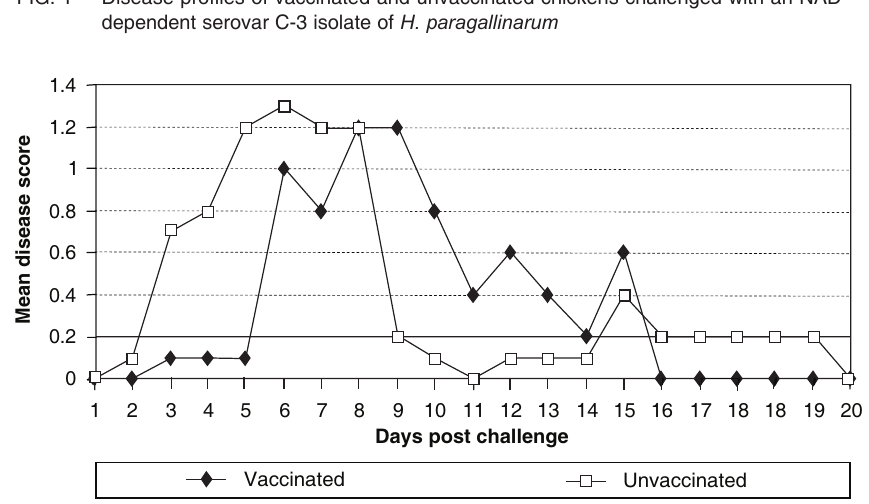
FIG. 1 Disease profiles of vaccinated and unvaccinated chickens challenged with an NAD- dependent serovar C-3 isolate of H. paragallinarum